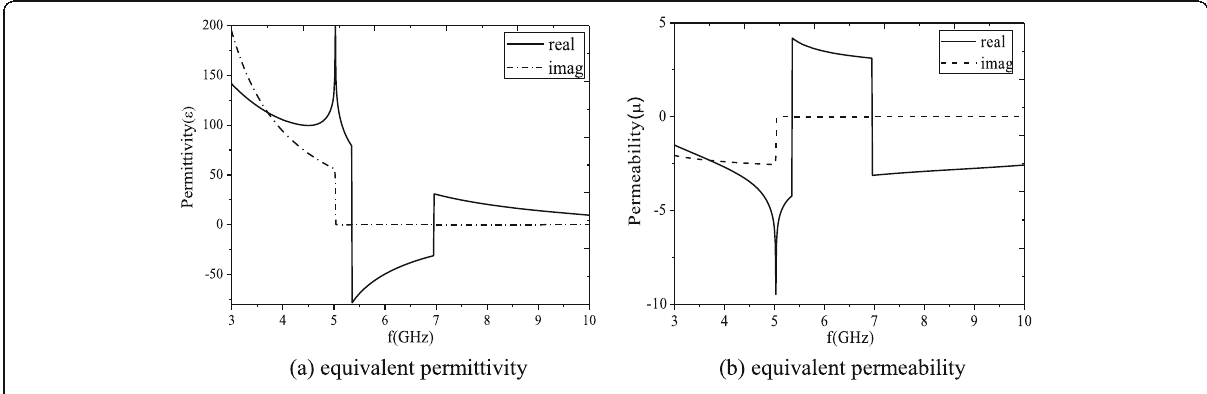
Fig. 3 Equivalent parameters of FSS unit. a Equivalent permittivity. b Equivalent permeability